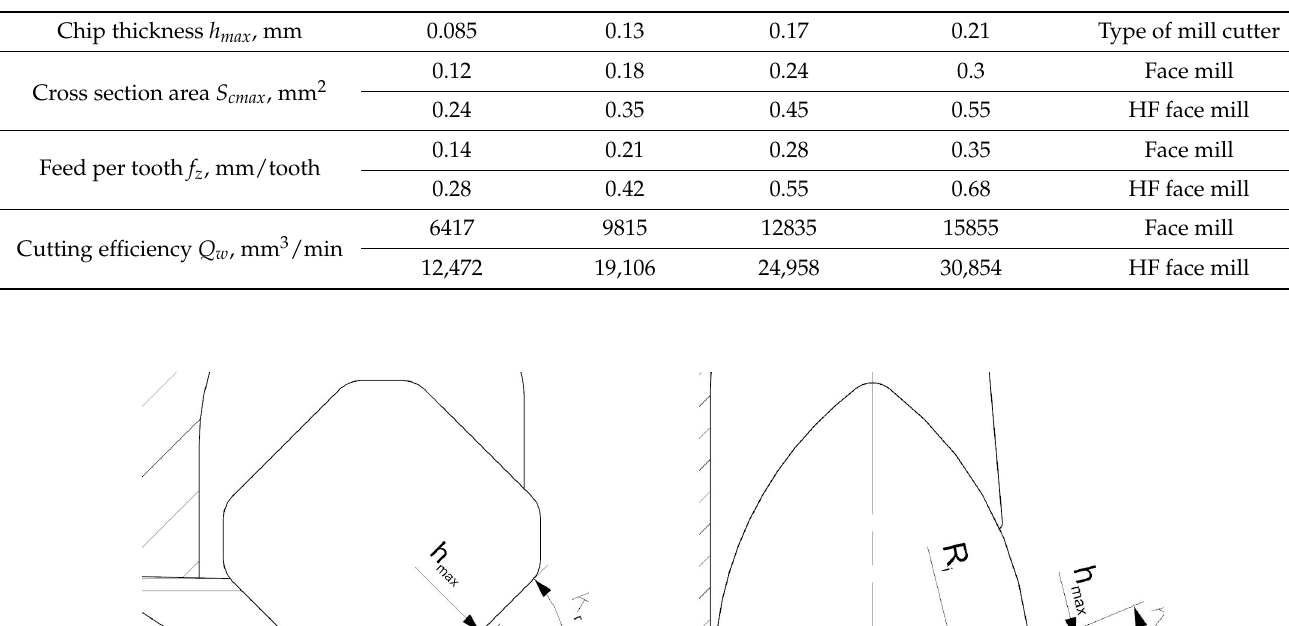
Table 1. The range of tested parameters.